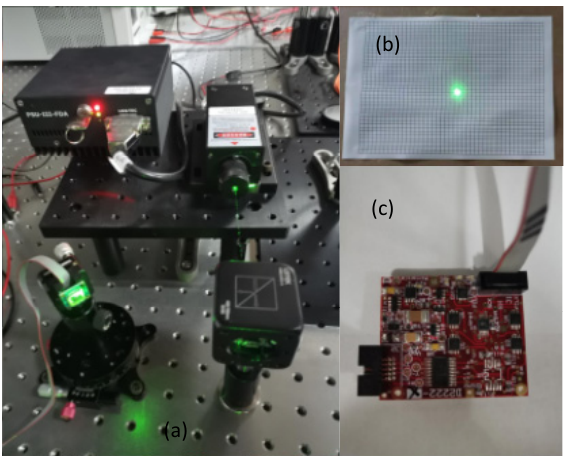
Figure 11. Scanning projection system: ( a ) scanning optical path; ( b ) scanning objective plane; ( c ) MEMS driver.